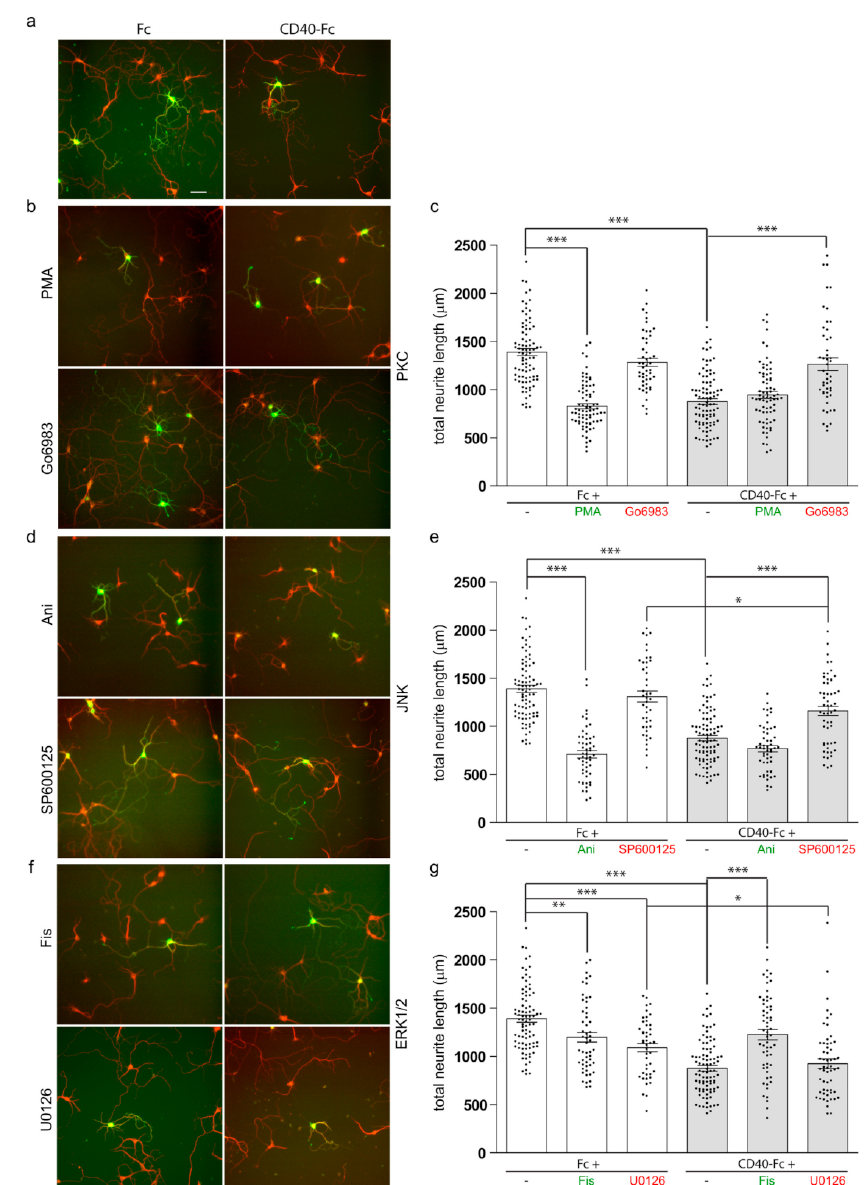
Figure 2. Effect of pharmacological reagents on neurite growth from MSNs. ( a , b , d , f ) Representative photomicrographs of Fc-treated and CD40-Fc-treated MSNs exposed to pharmacological reagents. ( c , e , g ) Quantification of the influence on total neurite length of pharmacological reagents. Cultures of striatal MSNs were established from E14 Cd40 − / − embryos. The cultures were treated 24 h after plating with either 1 µ g/mL of Fc (white bars) or 1 µ g/mL of CD40-Fc (grey bars) together with pharmacological manipulators of PKC (either 500 nM phorbol-12-myristate-13-acetate (PMA) or 500 nM Go6983) ( b , c ), JNK (either 50 nM Ani or 1 µ M SP600125) ( d , e ), and ERK1/ERK2 (either 1 µ M Fisetin (Fis) or 1 µ M U0126) ( f , g ). The neurons were double labelled for β III tubulin (red) and DARPP-32 (green) to identify MSNs after a total of 10 days in vitro. Scale bar, 50 µ m. For clarity, the activators are labelled in green and the inhibitors in red. In the scatter charts, mean ± s.e.m of at least three independent experiments are shown. The dots represent the data obtained from individual neurons (number of neurons per condition are given in Supplementary Materials). One-way ANOVA with multiple Newman–Keuls statistical comparison. Key statistical significance differences are indicated (*** p < 0.001, ** p < 0.01, and * p < 0.05). Comprehensive statistical analysis is provided in the Supplementary